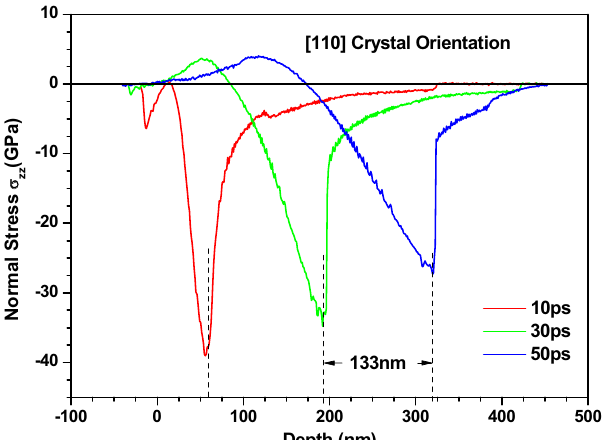
-100 Figure 5. Normal stress ( σ zz ) distribution of 450 nm 〈 110 〉 copper films under an absorbed laser intensity of 0.065 J/cm 2 at 10–50 ps time